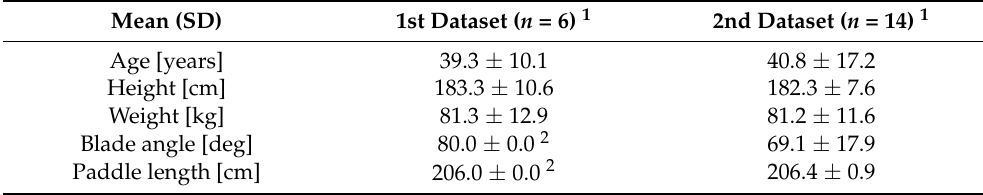
Table 1. The descriptive information of the study